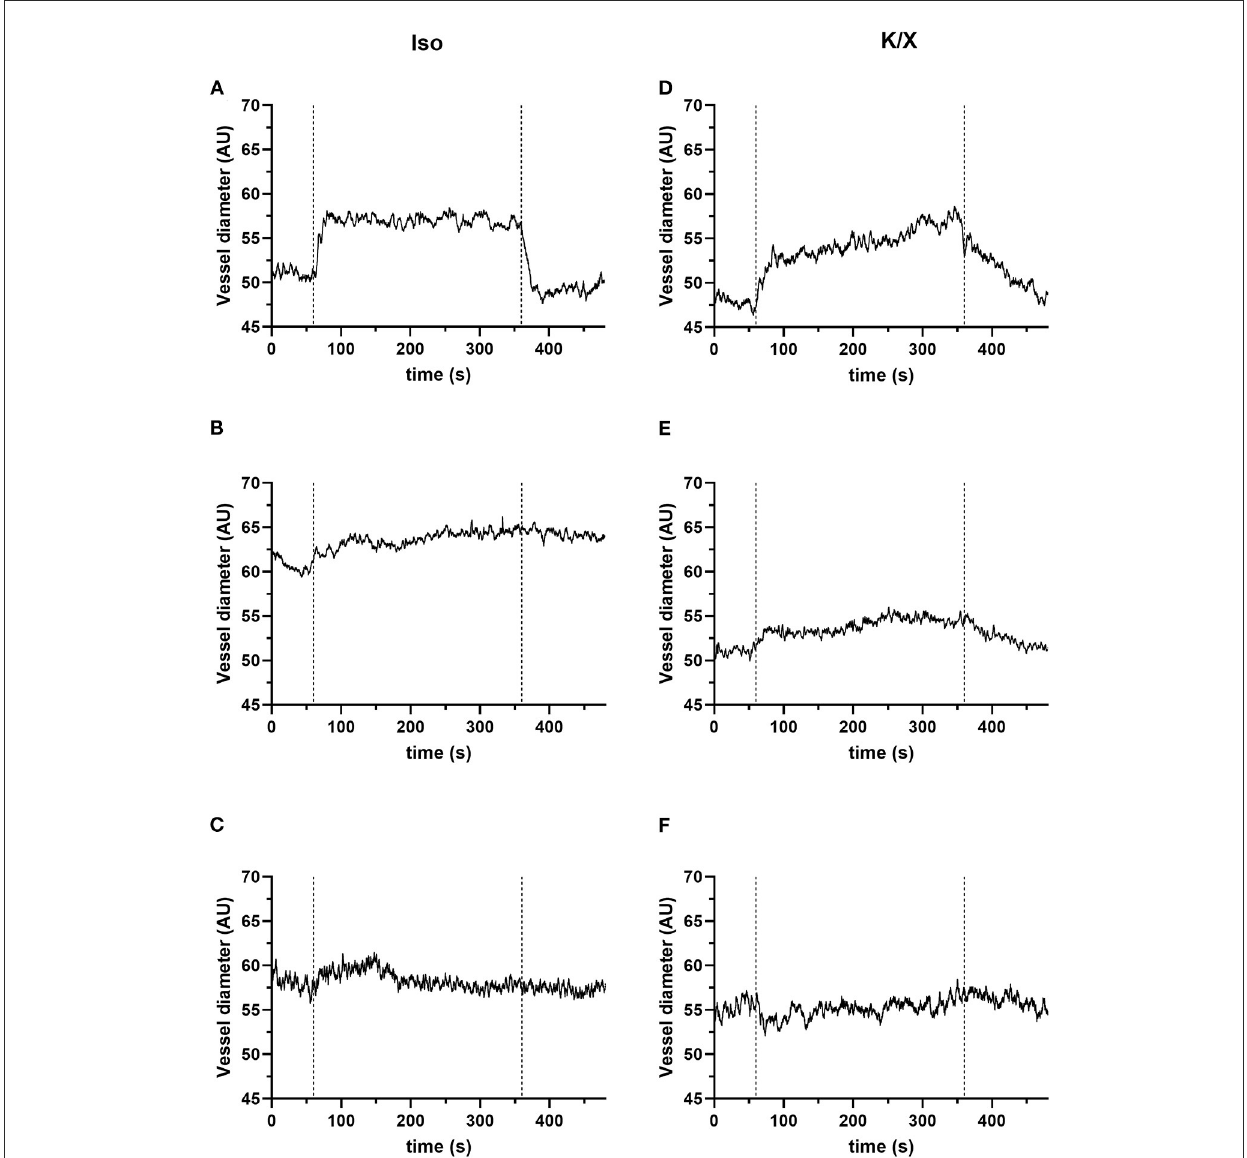
FIGURE6 Retinal reactivity to hypercapnia. The retinal reactivity is not consistent in both anesthetic protocols. They can be divided into good (A, D) , moderate (B, E) , and poor or no (C, F) reactivity. For the quantification of the vascular reaction, calculation of mean values of the vessel diameter (in arbitrary units, AU) for a 1-min baseline (immediately before the onset of hypercapnia) and the 5min during hypercapnia can be performed. For this exemplary illustration, n = 3 animals were used for the isoflurane protocol and n = 3 animals for the K/X protocol. Category good: (A, D) ; examples of pronounced vessel diameter increases to hypercapnia: (A) in the Iso protocol example, the mean value of the vessel diameter increased from 51.21 to 56.98AU, corresponding to an increase of 11.28%. (D) There were also clear responses in the K/X protocol with a vessel increase of 14.07% (an increase from 47.88 to 54.64AU). Category moderate: (B, E) ; examples of moderate responses to hypercapnia; (B) in the Iso protocol example, mean vessel diameter increased from 60.97AU at baseline to 63.74AU during hypercapnia, representing an increase of 4.6%. (E) In the example of the K/X protocol, the vessel diameter increased by 5.64% (baseline 51.06AU, hypercapnia 53.94AU). Category poor/no reactivity: (C, F) ; examples showing no reaction; (C) example from the Iso protocol (mean values: baseline 58.11AU, hypercapnia 58.23AU, corresponding to an increase of 0.22%).